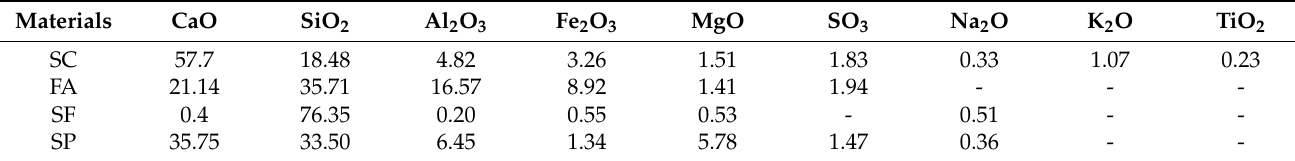
Table 1. Chemical compositions of gelling materials (kg/m 3 ).